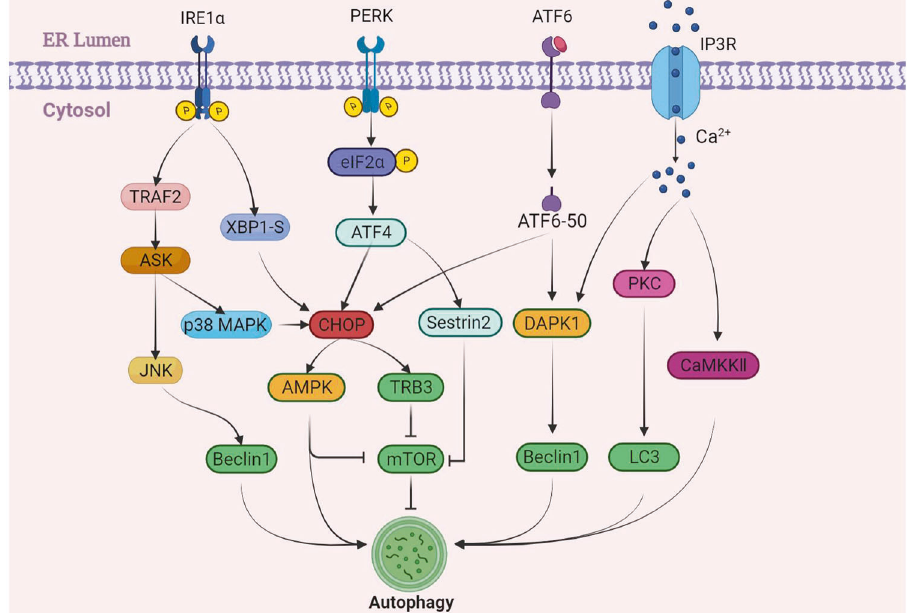
Fig. 2 The UPR activates autophagy. ERS mainly mediates autophagy through four pathways: PERK, IRE1 α , ATF6, and Ca 2 + , of which the key regulator is C/EBP homologous protein (CHOP). When ERS is activated, IRE1 α acts on Beclin1 through the tumor necrosis factor receptor- associated factor 2 (TRAF2) and Jun N-terminal kinase (JNK) pathway to promote autophagy; ATF6 activates its downstream death-associated protein kinase 1 to activate autophagy through Beclin1; all three UPR pathways can regulate autophagy by activating CHOP protein. In addition, Ca 2 + can also participate in autophagy through protein kinase C (PKC) and calcium/calmodulin-dependent protein kinase II